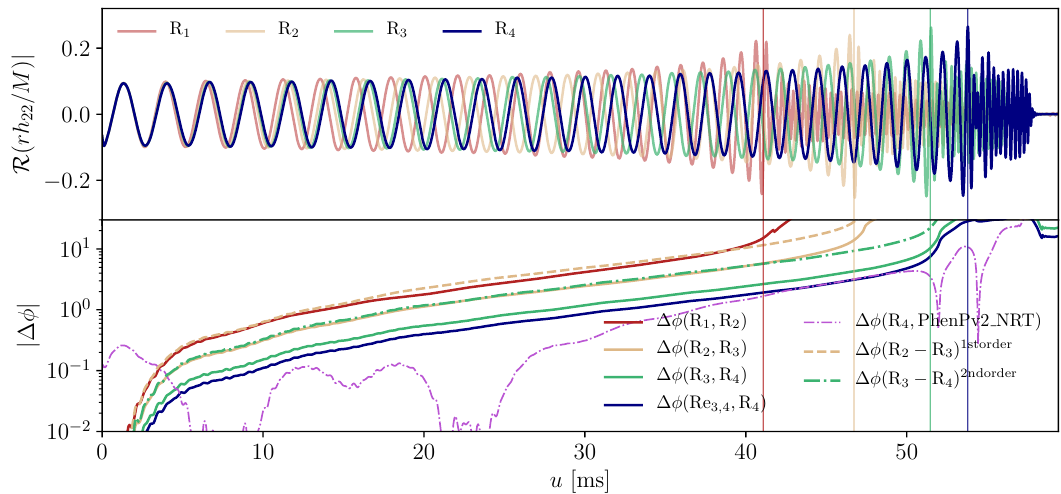
Figure 5. The top panel shows the (2,2)-mode of the GW signal for the different resolutions. The bottom panel shows the phase difference between the individual resolutions, where dashed lines show the phase difference rescaled to an assumed first or second order convergence. In addition, we show the phase difference with respect to a Richardson extrapolated waveform using resolutions R3 and R4, denoted by Re 3,4 . We also include the phase difference of Re 3,4 with respect to the waveform approximant IMRPhenomPv2_NRTidal [71] (purple dash-dotted line), denoted as PhenPv2_NRT. Vertical lines mark the moments of merger for the individual